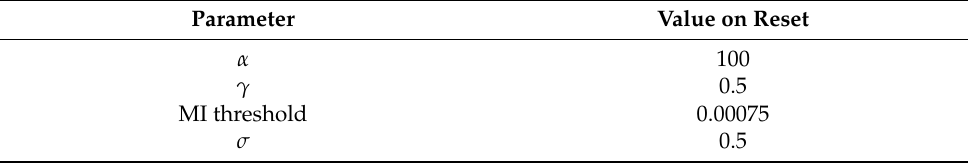
Figure 5. Aggregate throughput of CBR traffic when source node “S” is using MPTCP with coupled congestion control linked-increases algorithm (MPTCP-CC-LIA).